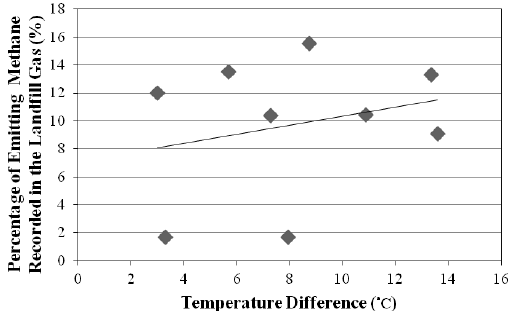
Figure 6. Relationship between the Percentage of Emitting Methane Recorded in GM-2 and the Temperature for 2007 (R 2 =